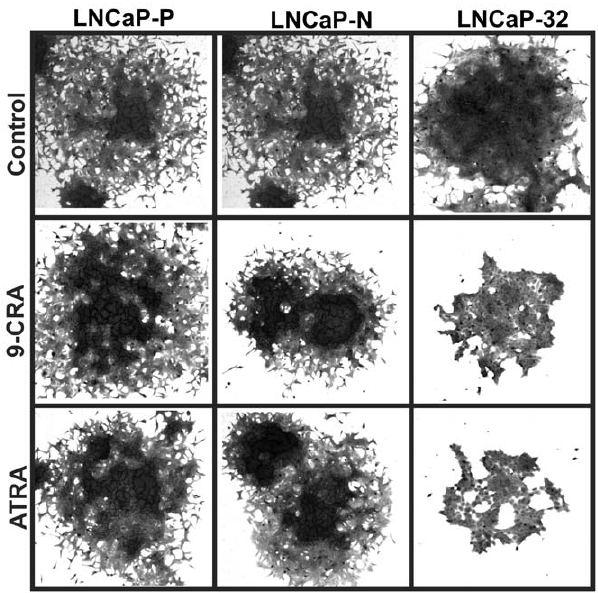
Figure 8. Retinoids affect the morphological phenotype of Cx32-expressing LNCaP cells. The morphological appearance of colonies of LNCaP-P, LNCaP-N and LNCaP-32 cells upon treatment with 9-CRA and ATRA is altered. Cx-null LNCaP-P and LNCaP-N cells form colonies of moderately packed cells with scattered edges whereas Cx32-expressing LNCaP-32 cells form colonies of compact cells with smooth edge. Note that upon treatment with 9-CRA and ATRA, LNCaP-P and LNCaP-N form colonies of more tightly packed cells with relatively smoother edges. Note also that these changes are profound in LNCaP- 32 cells. For direct comparison of colony size and cell shape, all photographs were taken at the same magnification (40 6 ). Colonies were fixed and photographed at day 21 (LNCaP-P and LNCaP-N) and